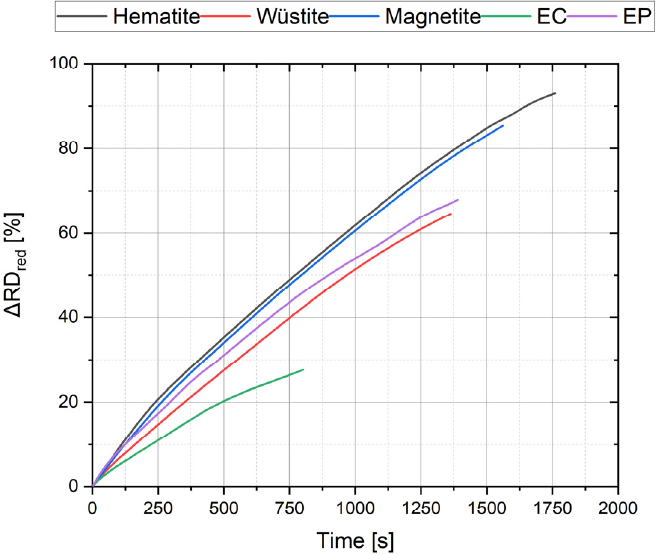
Figure 5. Change in the degree of reduction during hydrogen injection ( ∆ RD red ) for various charged materials.